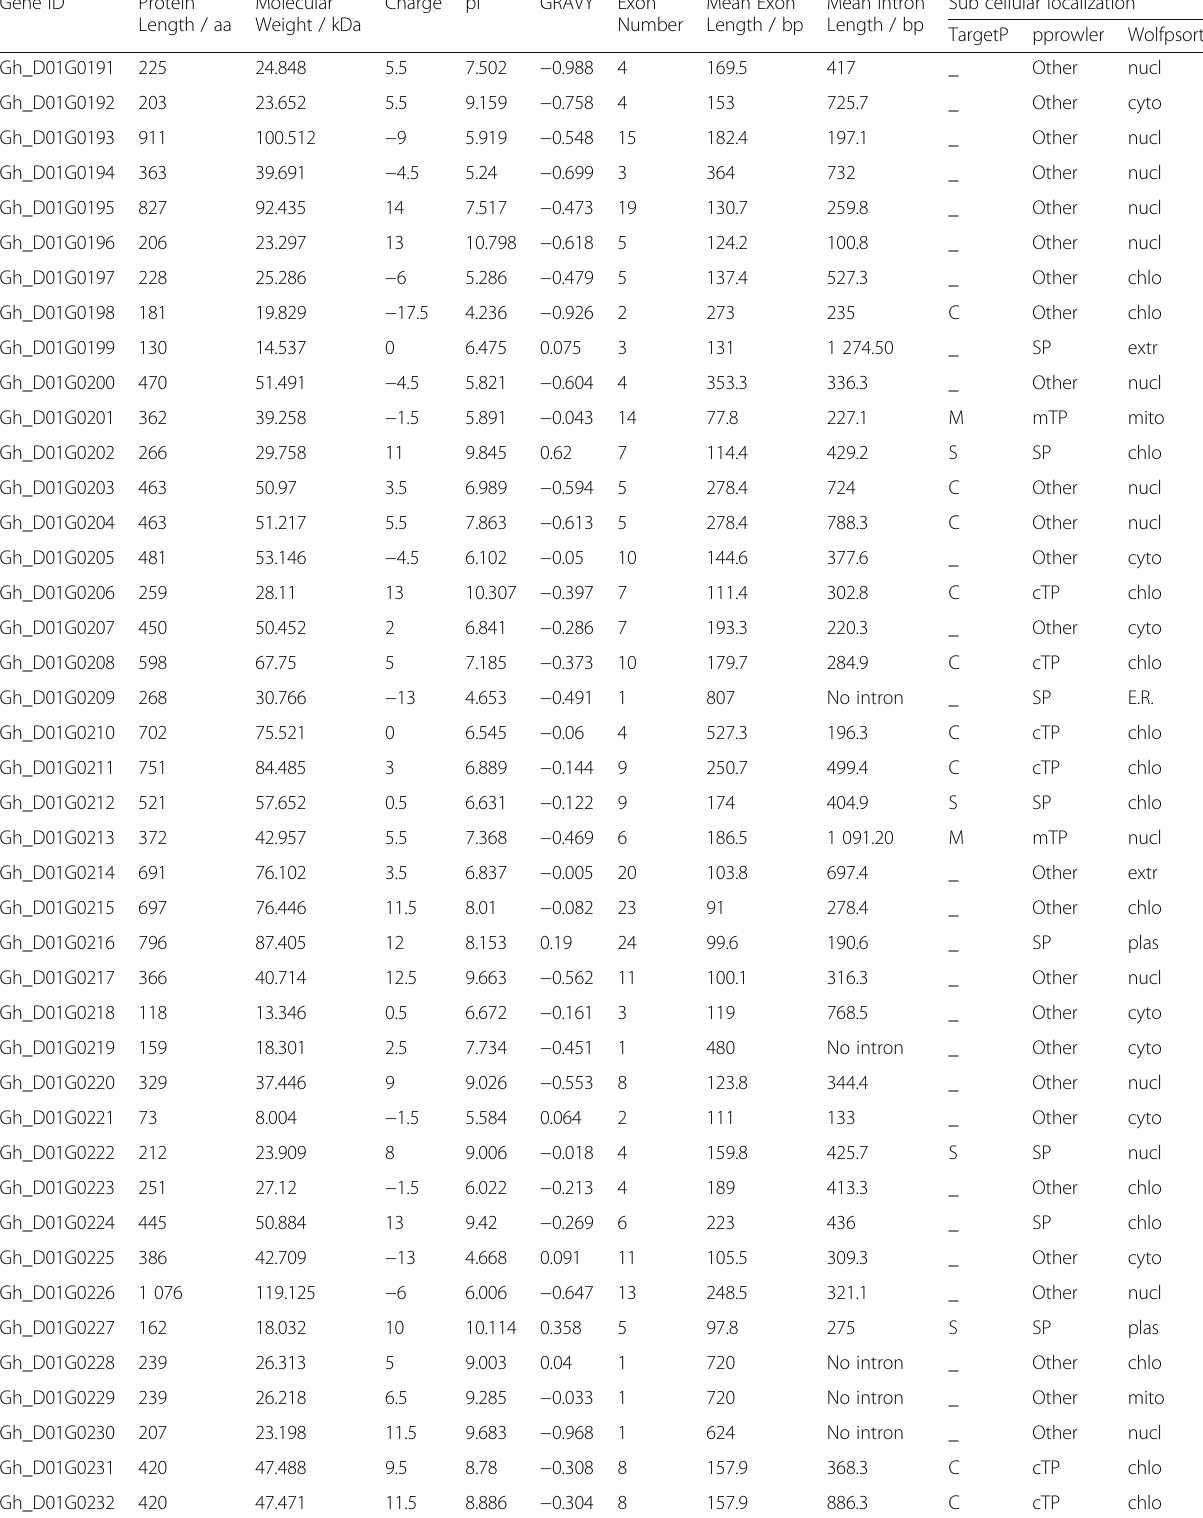
Table 4 Physiochemical properties and sub cellular localization prediction of the mined genes within the major clusters of the consistent QTLs